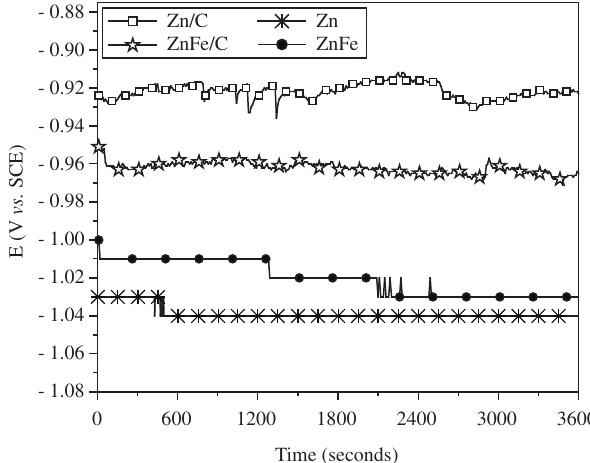
Figure 2. Evolution of open circuit potential with the time. in Zn, ZnFe, Zn/C and ZnFe/C